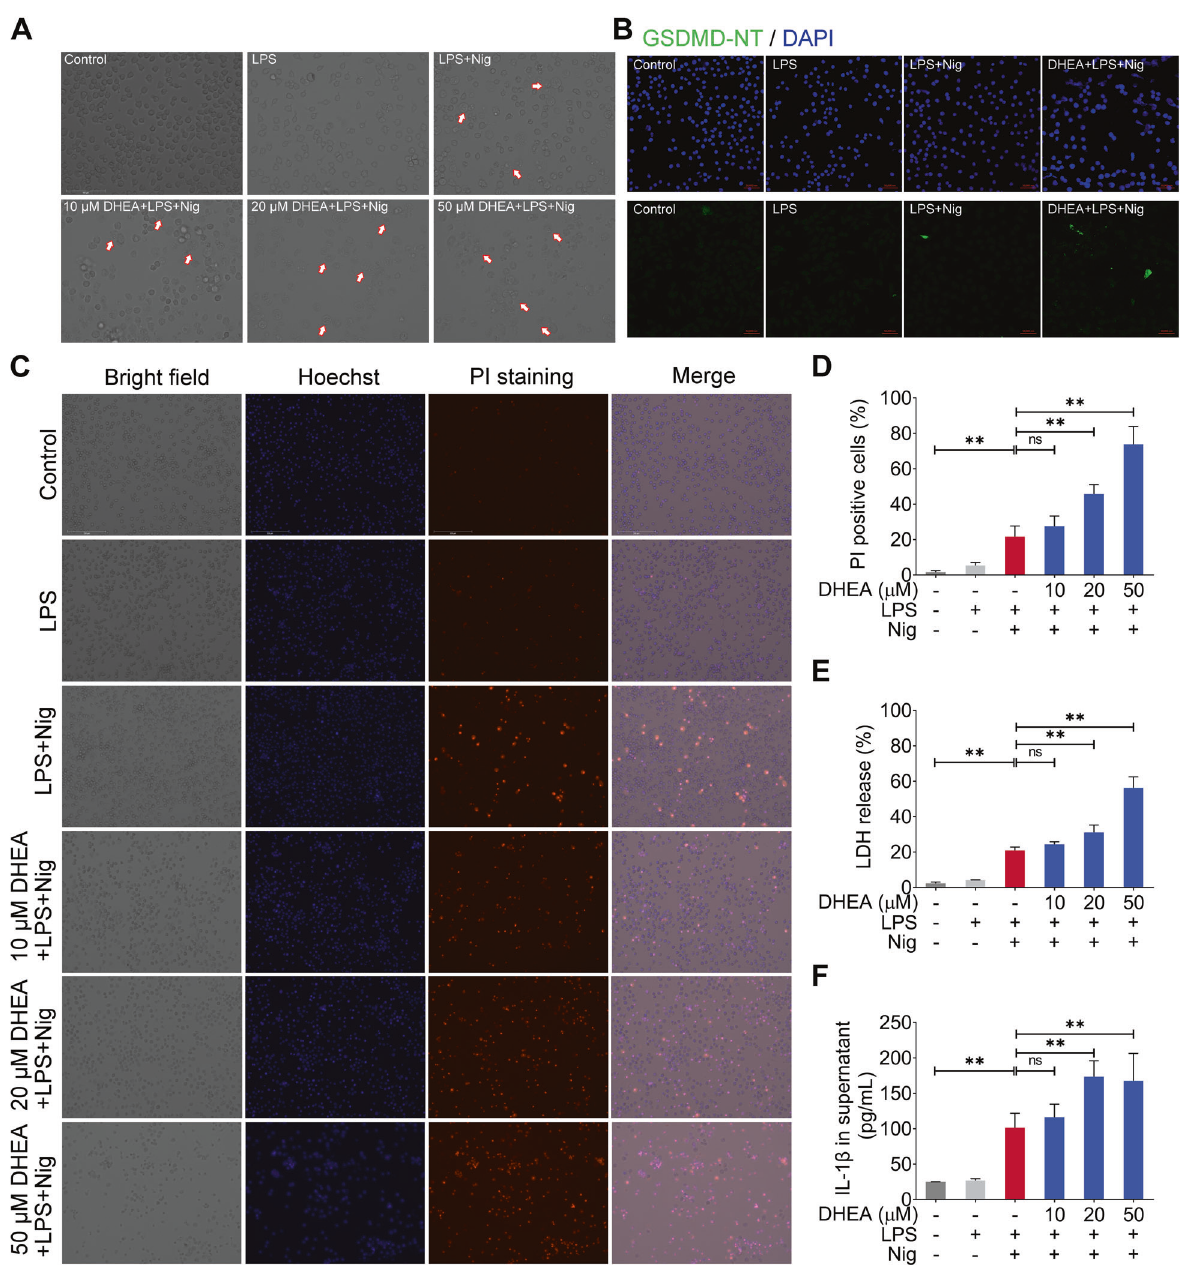
Fig. 2 DHEA promotes Nig-induced pyroptosis in LPS-primed macrophages. A Cells were pre-treated with different doses of DHEA (0, 10, 20, 50 μ M) for 1 h and primed with LPS for 4 h; then stimulated with nigericin (Nig) for 1 h. Cell morphology was observed by light microscopy, the red arrows represent the cells that burst due to pyroptosis, scale bar = 100 μ m. B The GSDMD-NT protein levels were analyzed by immuno fl uorescence, scale bar = 50 μ m. C , D PI-positive dead cells in 5 randomly selected fl uorescence microscope images were counted by Image J software, scale bar = 200 μ m. E The cell death was measured by detecting the lactate dehydrogenase (LDH) release (%) in cell culture supernatant. F IL-1 β content in cell culture supernatant. Data are presented as means ± SEM ( n = 4). * P < 0.05, ** P < 0.01, compared with the respective may prevent GPER-induced autophagy inhibition. To con fi rm this DHEA treatment that presented in Fig. 4A, G1 treatment conjecture, we used AMPK inhibitor compound C (CC) and mTOR decreased the expression levels of LC3 II and p62 to some extent inhibitor rapamycin (Rapa), respectively, to block the activation of (Fig. 4B), and G1 treatment failed to induce activation of AMPK/ AMPK/mTOR signal in LPS-treated macrophages. The results mTOR (sFig. 3A and B). Interestingly, we found that ERK inhibitor showed that pre-treated with both Rapa and CC enhanced the U0126 treatment reduced the expression levels of LC3 II and p62 phosphorylation level of ERK in cells after DHEA treatment, and CC in LPS-treated macrophages (sFig. 4A), implied that activation of treatment also induced a signi fi cant up-regulation in p62 protein ERK induces autophagy, which is consistent with previous reports level (Fig. 5A); which implied that AMPK/mTOR also involved in the [33]. Thus, we speculated that GPER activation partially inhibited inhibition of ERK signaling, and the activation of AMPK signaling ERK-induced autophagy, and the activating AMPK/mTOR signal